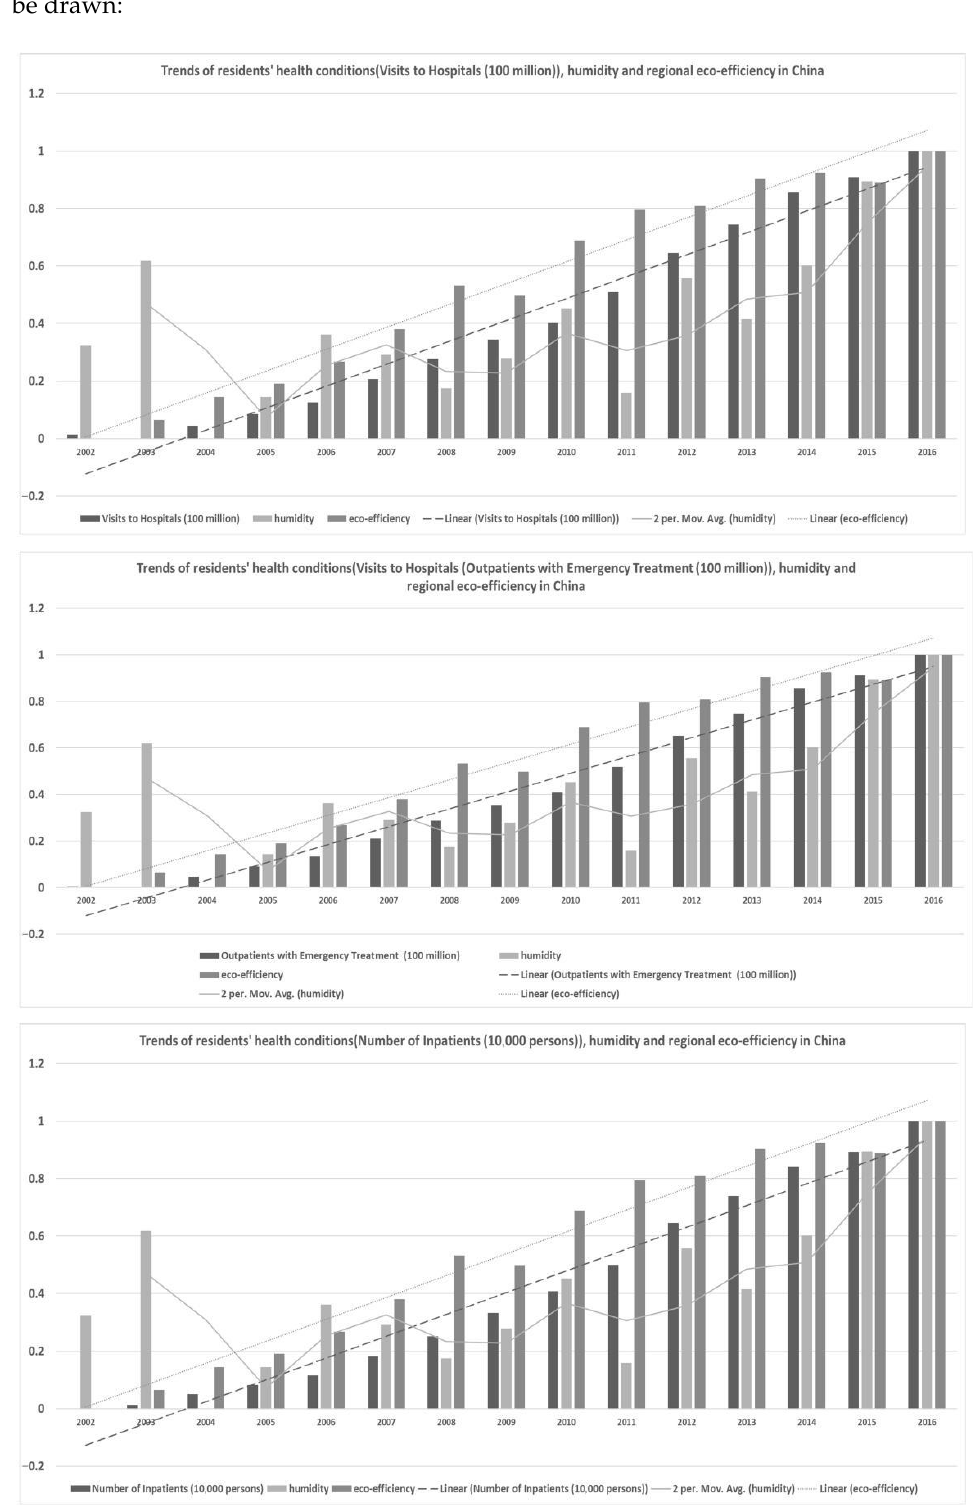
Figure 3. Trends of RHC , humidity, and REE in China.